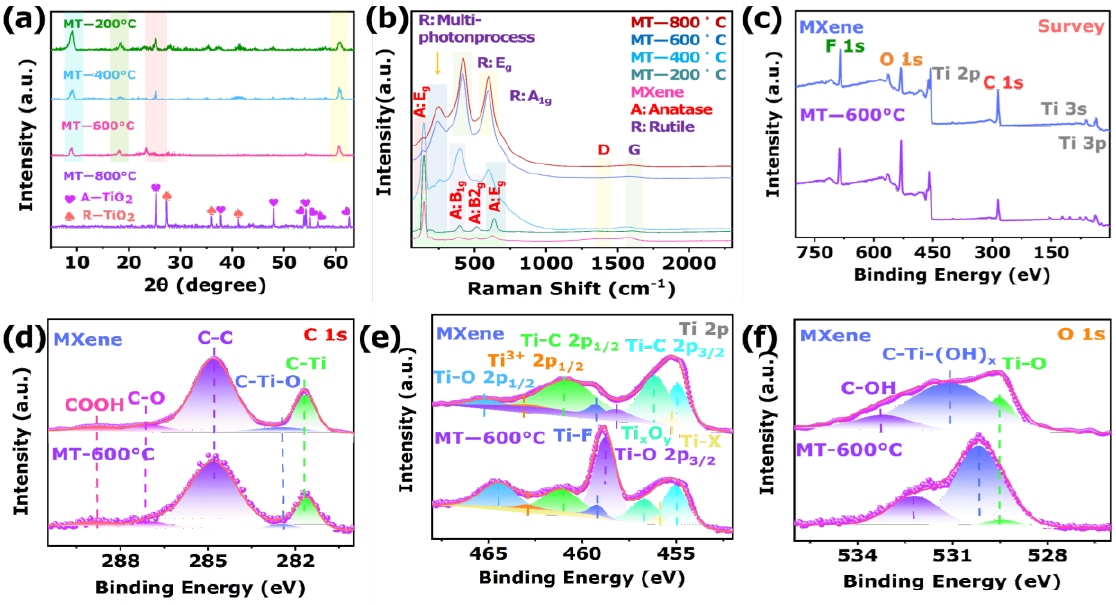
Figure 2. XRD patterns of ( a ) Ti 3 AlC 2 , MXene, MT-200 ◦ C, MT-400 ◦ C, MT-600 ◦ C, MT-800 ◦ C. ( b ) Raman spectra of MXene, MT-200 ◦ C, MT-400 ◦ C, MT-600 ◦ C, MT-800 ◦ C. XPS spectra of MXene and MT-600 ◦ C: ( c ) survey, ( d ) C 1s, ( e ) O 1s, and ( f ) Ti 2p.